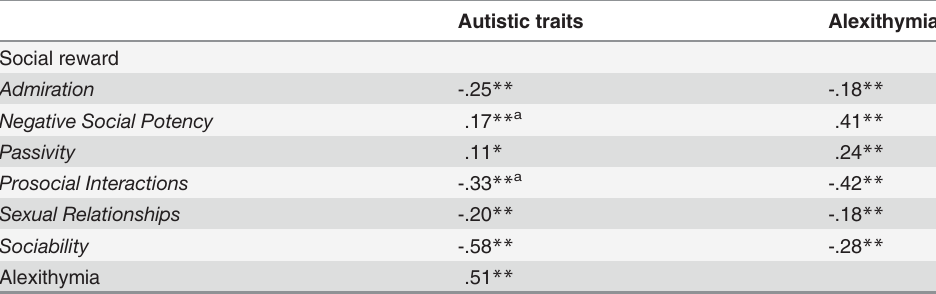
Table 2. Correlations between autistic traits, alexithymia and social reward.